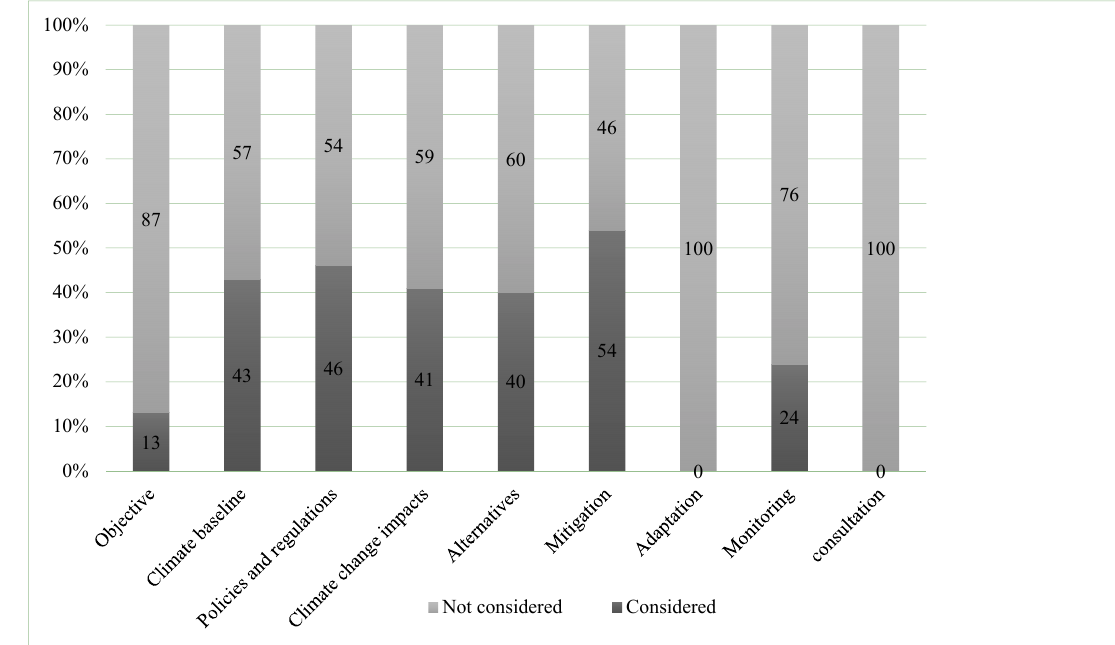
Figure 5. Percentage of EIS that addressed the climate change criteria.